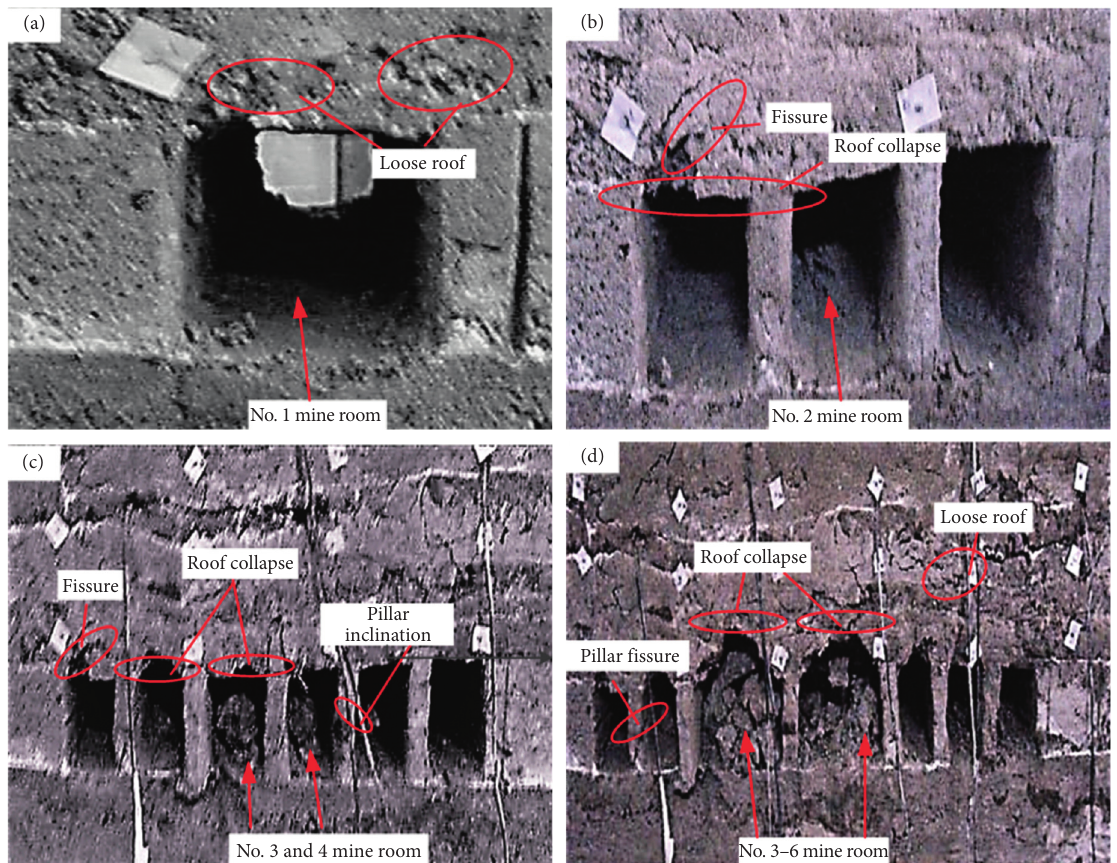
Figure 7: Deformation and failure characteristics of the roof for the 3 m ore pillars: (a) first step; (b) second step; (c) third step; (d) fourth